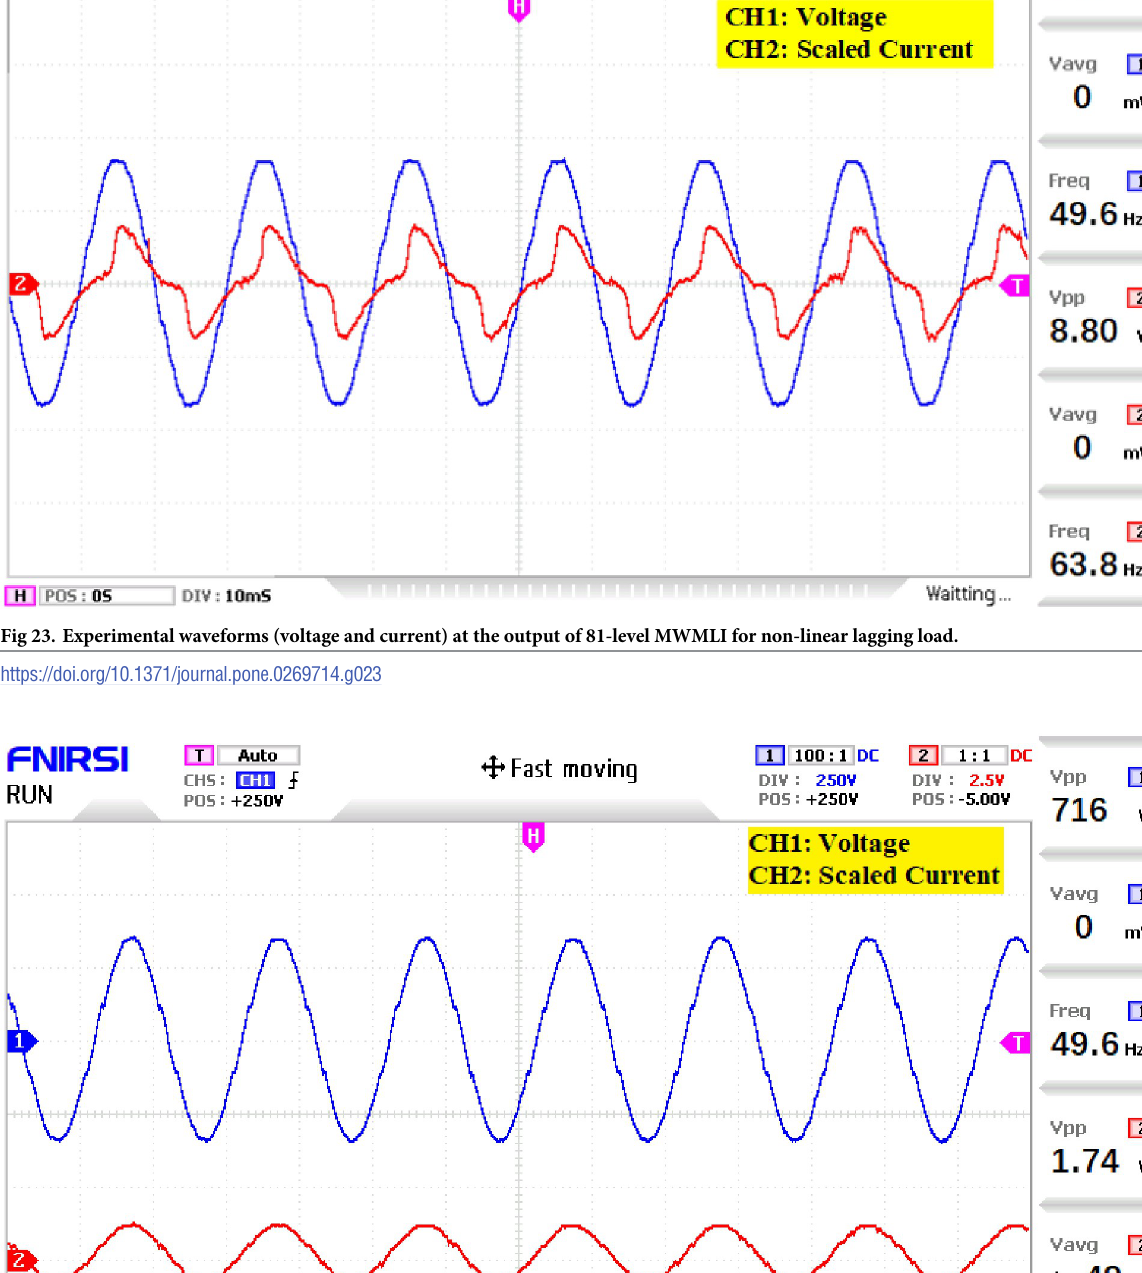
PLOS ONE | https://doi.org/10.1371/journal.pone.0269714 June 22,